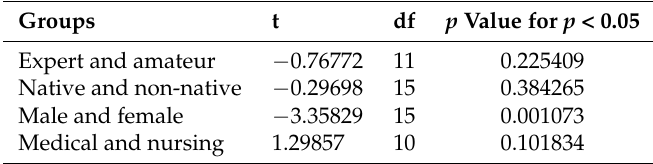
Figure 9. NASA-TLX overall score comparison among HMT identified groups. Table 5. One-tailed T-Test analysis on the NASA task load index (NASA-TLX) overall score for different